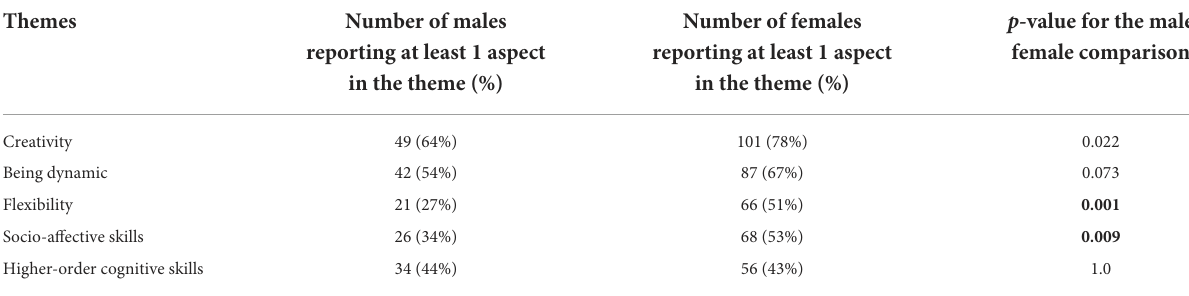
TABLE 4 Sex differences across the themes of self-reported positive aspects in men and woman with an ADHD diagnosis.